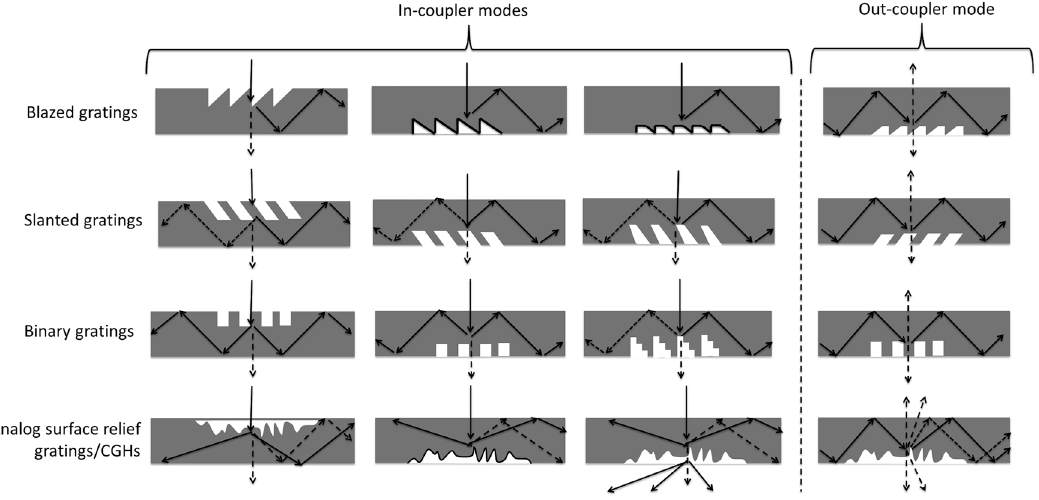
Figure 12: Surface-relief grating types used as waveguide combiner in-couplers and out-couplers. Solid lines indicate reflective coatings on the grating surface, and dashed lines indicate diffracted